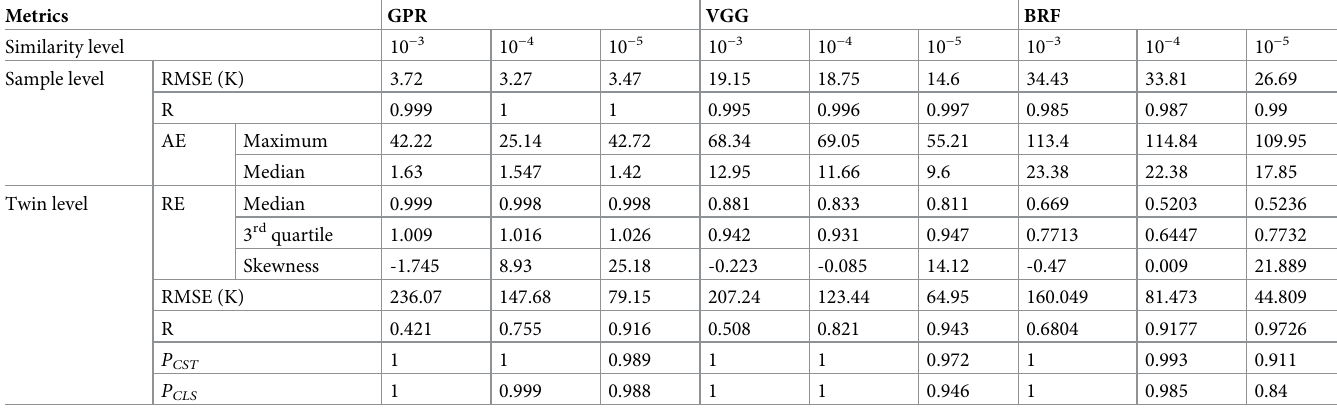
Table 6. Retrained model performance on test sets from different similarity level. Metrics Similarity level Sample